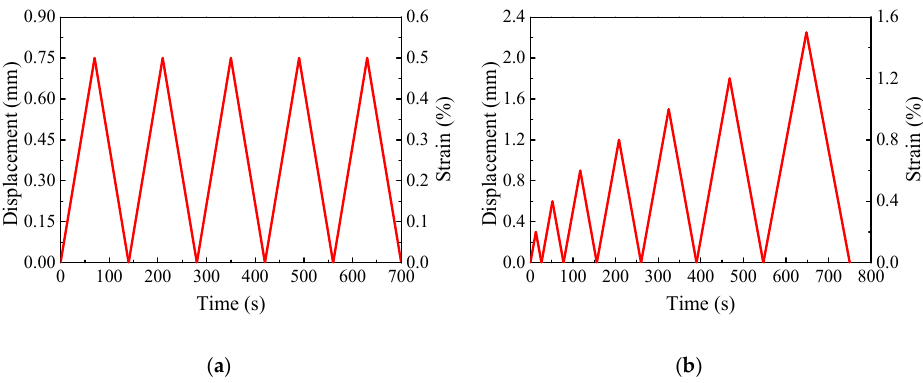
Figure 3. Cyclic loading paths: ( a ) Loading Type I; ( b ) Loading Type II.